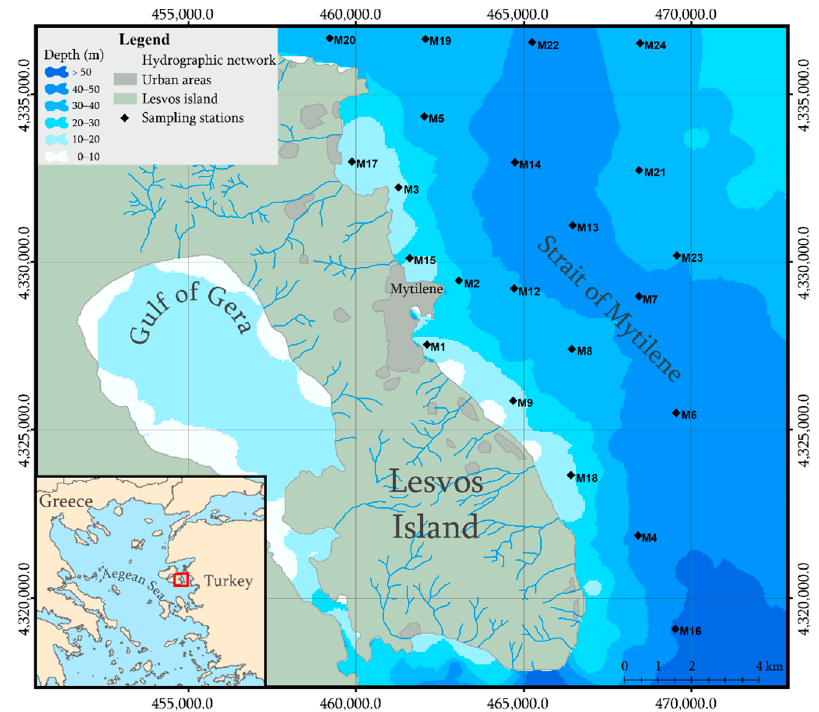
Figure 1. The Strait of Mytilene and the sampling sites location (Coordinate system: Universal Transverse Mercator/Zone 35).